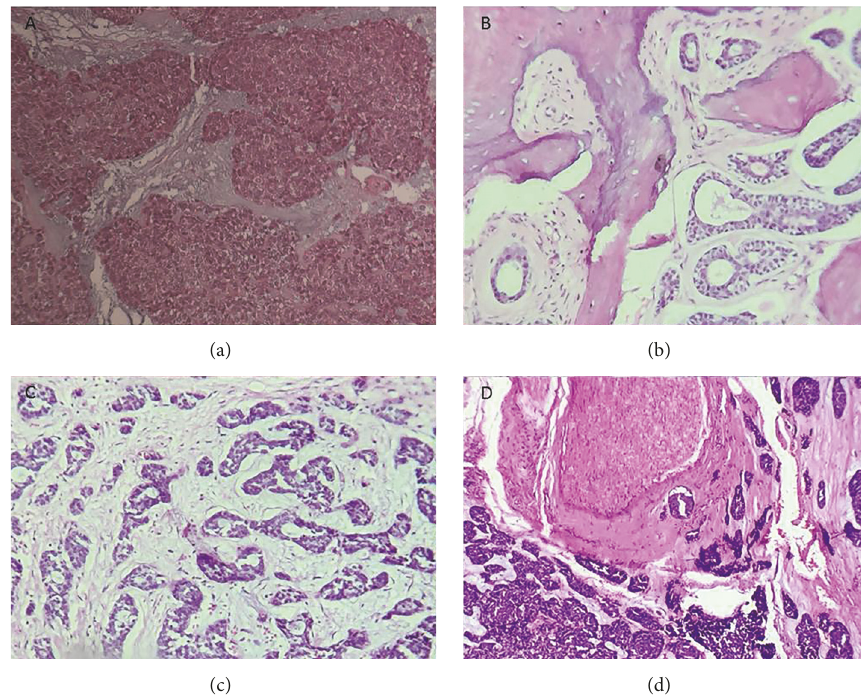
Figure2: (a)Nests ofneoplasticcells with peripheral palisading patternwithin fibromyxoid stroma(Hematoxylin and eosinstaining, original magnification × 20). (b) Marrow involvement of orbital and maxillary sinus bones. (c) Neoplastic cells have dark hyperchromatic nuclei arranged in cribriform, solid nests, and trabecular formations. (d) Perineural invasion in the depth of tumor is evident (Hematoxylin and eosin stain, original magnification ×